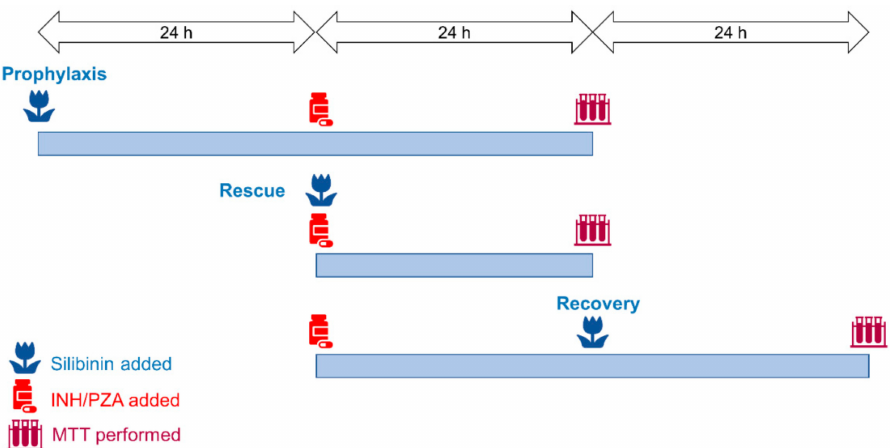
Figure 1. Treatment scheme involving silibinin’s role as a prophylactic, rescue, and recovery